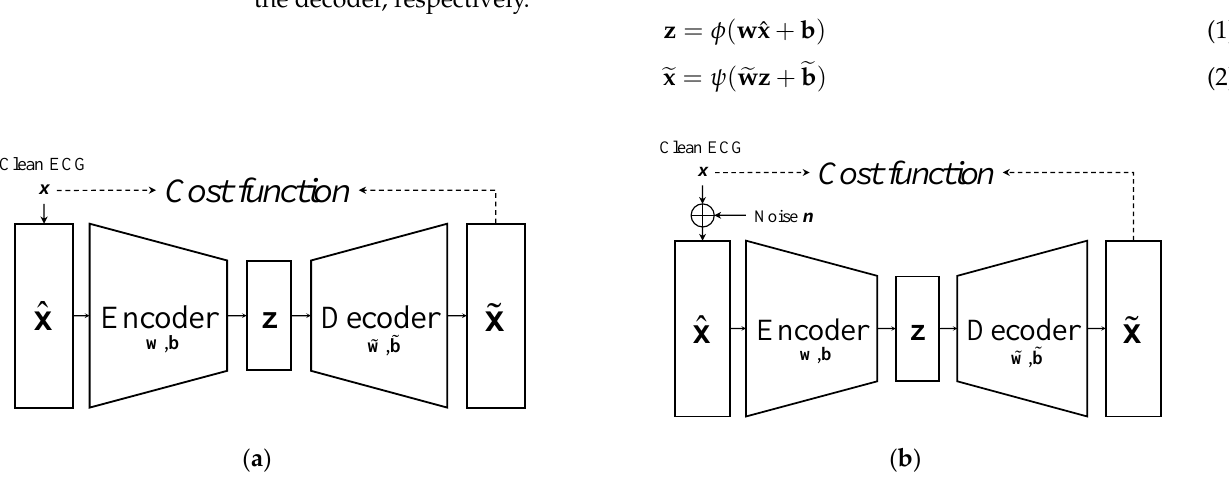
Figure 2. Architecture of ( a ) AE and ( b ) DAE.